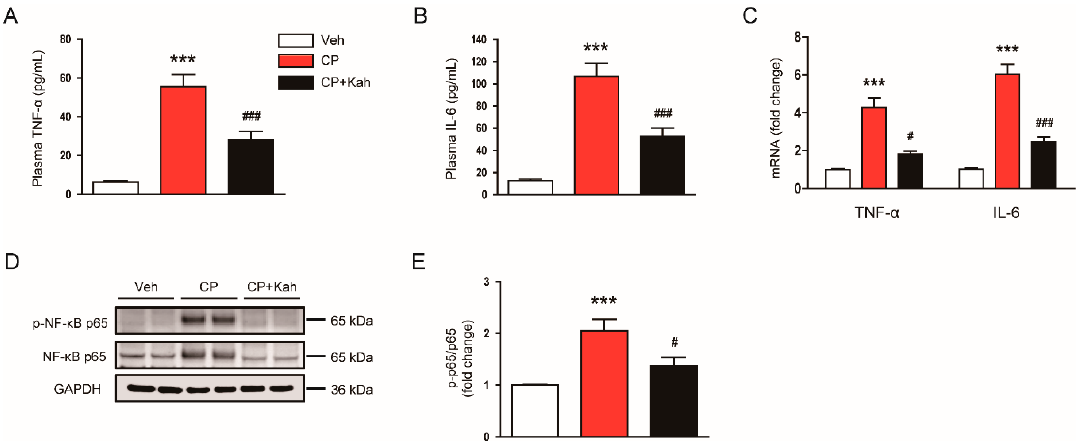
Figure 9. E ff ect of kahweol on inflammatory cytokine production and nuclear factor- κ B (NF- κ B) signaling in cisplatin-injected mice. ( A ) Plasma tumor necrosis factor- α (TNF- α ) levels. ( B ) Plasma interleukin-6 (IL-6) levels. ( C ) The mRNA levels of TNF- α and IL-6. ( D ) Western blotting of p-NF- κ B p65. ( E ) Quantification of Western blot for p-NF- κ B p65. GAPDH was used as an internal control. n = 8 per group. *** p < 0.001 vs. Veh. # p < 0.05 and ### p < 0.001 vs.